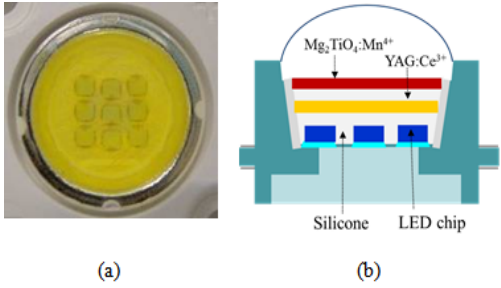
Fig. 1: Photograph of a WLEDs structure: (a) Actual WLEDs, (b) Illustration of pc-WLEDs model with red phosphor layer Mg 2 TiO 4 :Mn 4+ , and yellow phosphor layer YAG:Ce 3+ .